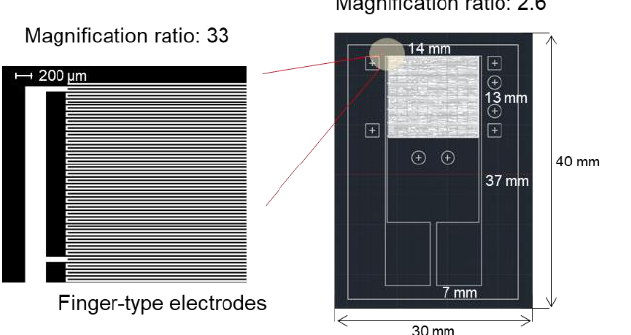
Figure 1. Designed mask pattern for a unit cell ( right ) and enlargement of the finger-type elec- trodes ( left ).